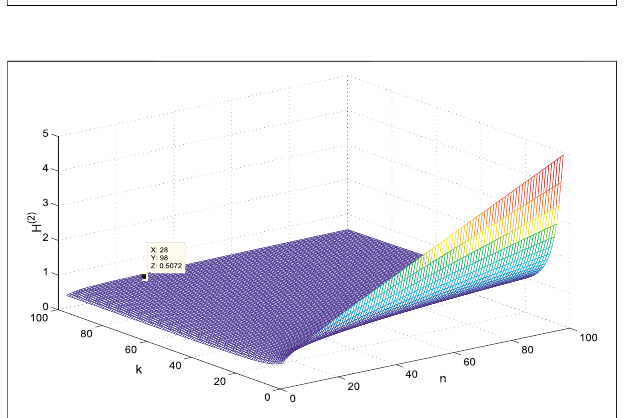
FIGURE 13 | The change of H (2) for C .